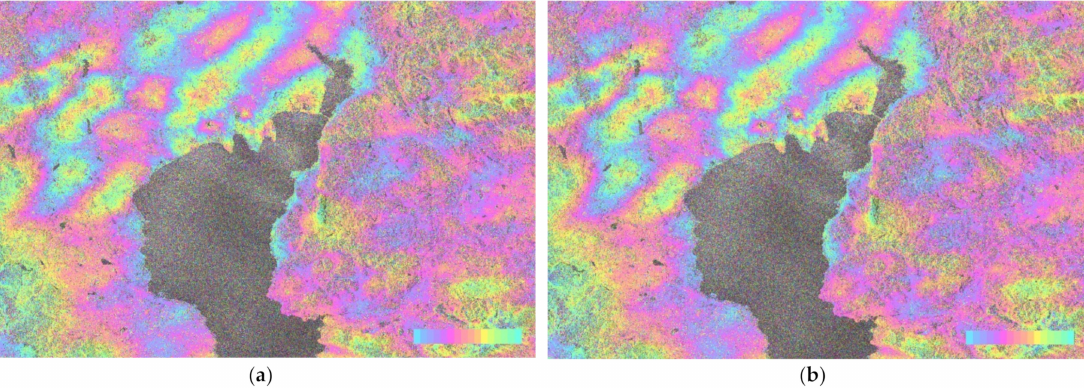
Figure 11. Comparison of the two processing methods: ( a ) filtering with conventional data processing, ( b ) filtering with spark parallel